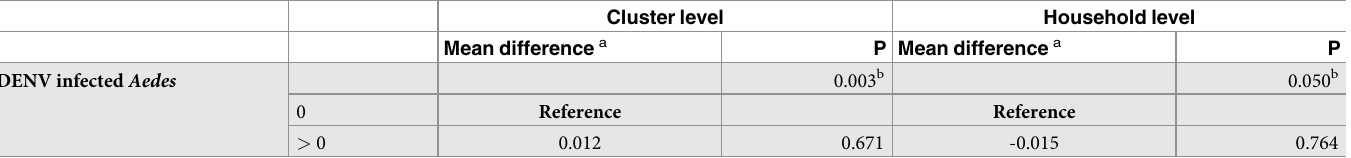
Table 5. Multivariate mixed linear model of human immune response to Nterm-34kDa Aedes salivary peptide or MEI and the presence of DENV infected Aedes in the